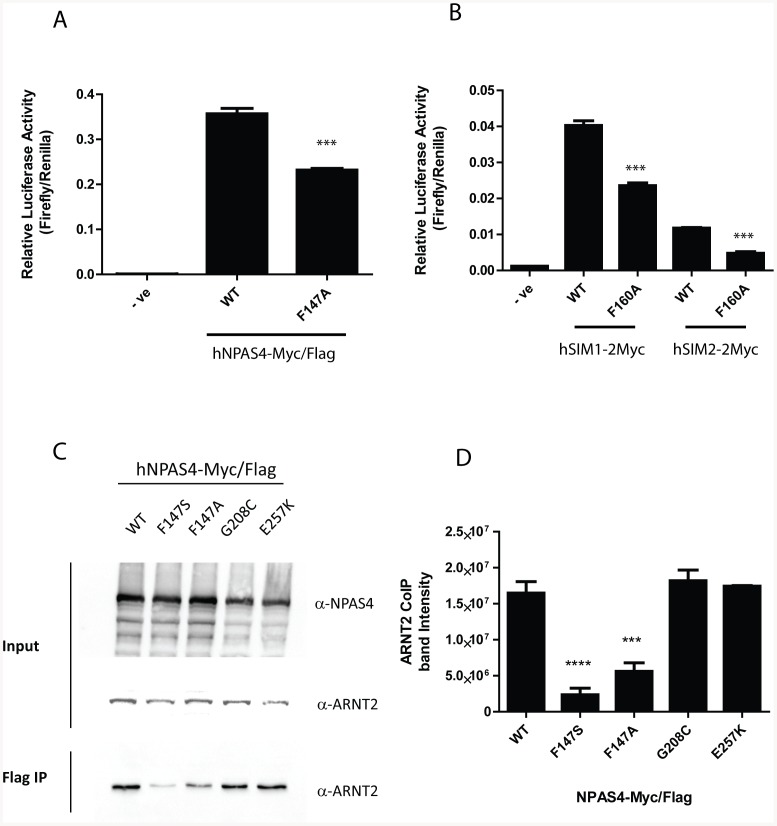
NPAS4.F147A, SIM1.F160A, and SIM2.F160A show reduced activities on a reporter gene.A, Comparison of WT NPAS4-mycFlag and NPAS4.F147A-mycFlag activities on reporter gene 6xCME-Luc in HEK293T cells transfected with NPAS4-MycFlag and ARNT2 expression vectors. B, Comparison of WT SIM-2myc proteins with SIM1.F160A-2myc and SIM2.F160A-2myc variants on reporter gene 6xCME-Luc in HEK 293T cells cells transfected with SIM1-2Myc, SIM2-2Myc and ARNT2 expression vectors. C. Immunoblotting of whole cell extracts and α-Flag coimmunoprecipitates from HEK293T cells transiently transfected with NPAS4-MycFlag. α-Flag Abs used to detect NPAS4-MycFlag and α-ARNT2 Abs used to detect endogenous ARNT2. D. ARNT2 coimmunopreciption band intensity quantitation of 3 independent α-Flag coimmunoprecipitation experiments. Data are mean relative luciferase activities ±SEM of 3 experiments. Statistical significance is calculated using an unpaired two tailed students t-test (A and B) or ANOVA (D) compared to WT.***p<0.001, ****p<0.0001.